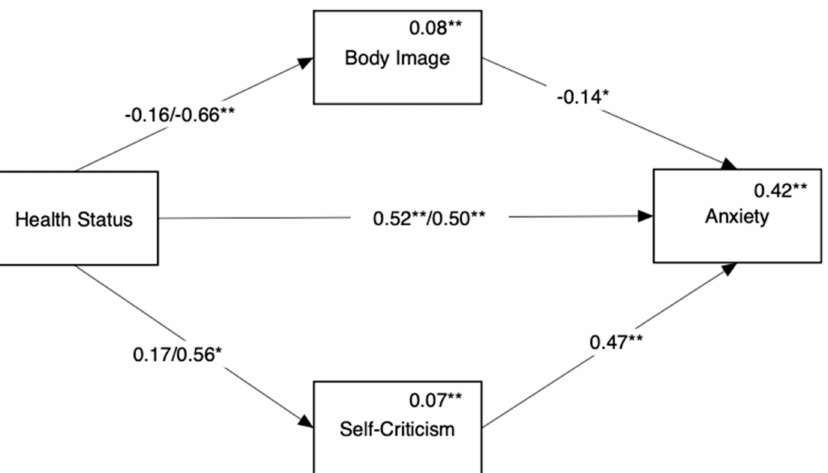
Figure 3. Mediation of the link between disease status and anxiety by body image and self-criticism. Reference group for comparison in the healthy controls. Numbers above the direct links are standard- ized regression coefficients. For paths originating from disease status, coefficients for endometriosis only appear on the left and coefficients for endometriosis ACI appear on the right. Numbers above variable names are multiple squared correlations. * p < 0.05, ** p <